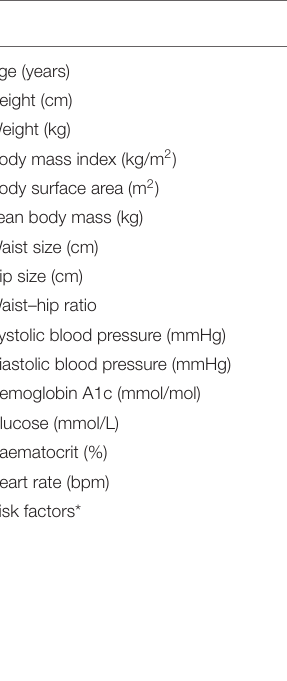
TABLE 1 | Study population characteristics.